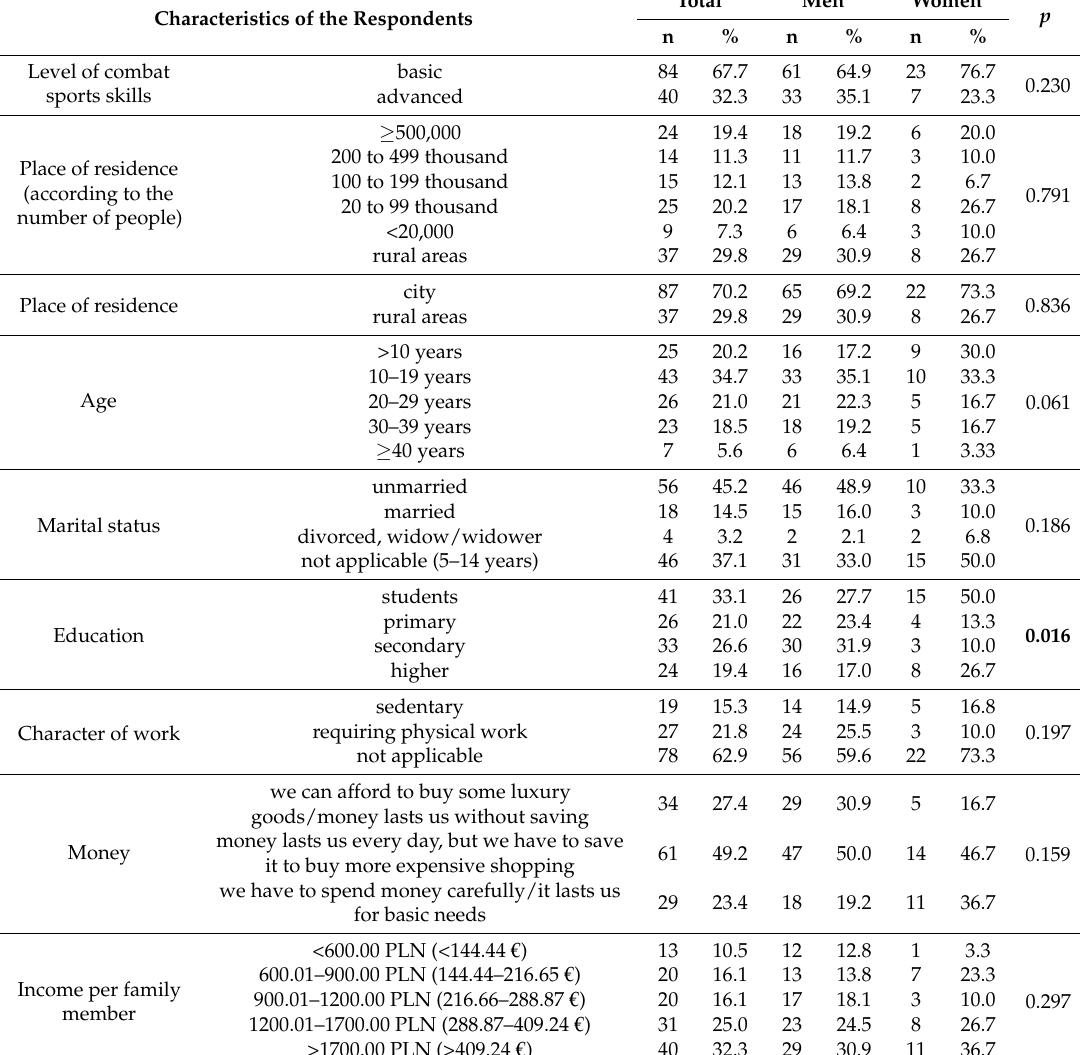
Table 2. Characteristics of Poles (n = 124) who reported practicing combat sports in the period studied (either professionally or recreationally) depending on sex and significance of differences based on the chi–squared